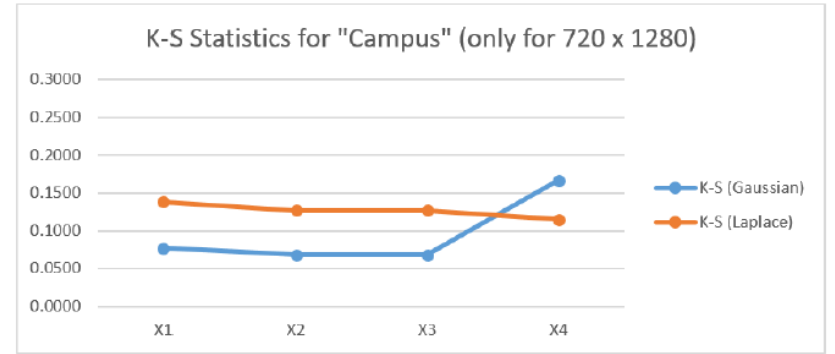
Figure 8. Kolmogorov-Smirnov Test Statistics for Campus.